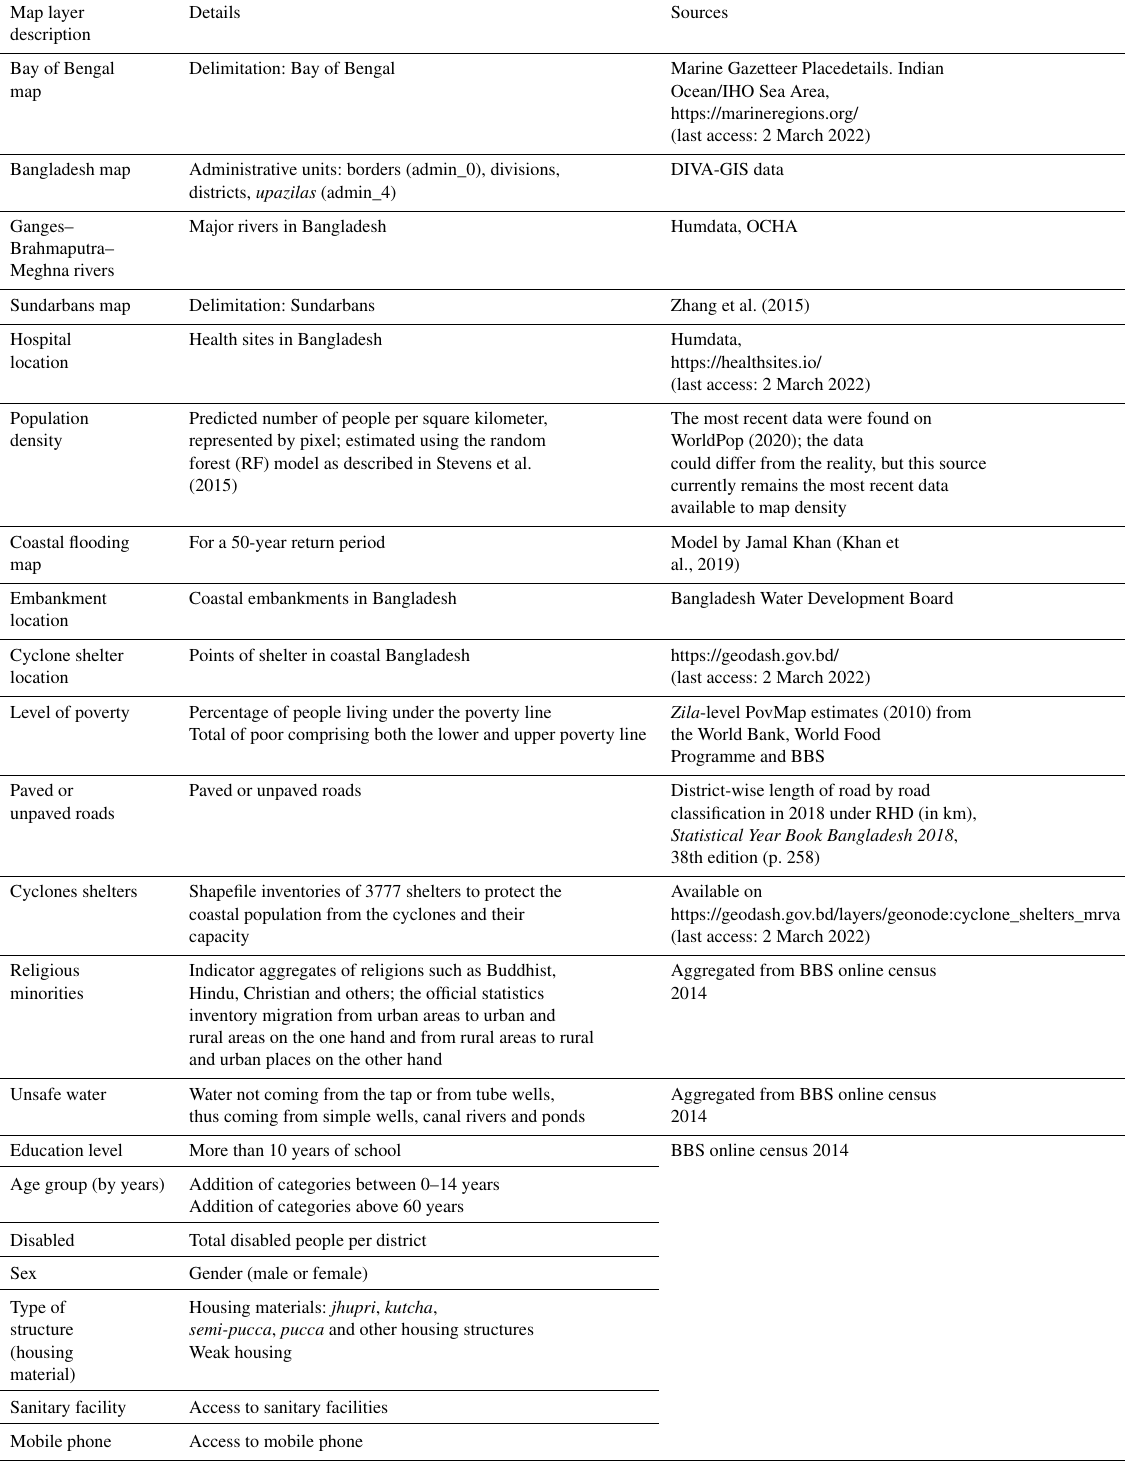
Table D1. Map layer sources and description used for cartography. GIS: geographic information system. Humdata: Humanitarian Data. OCHA: United Nations Office for the Coordination of Humanitarian